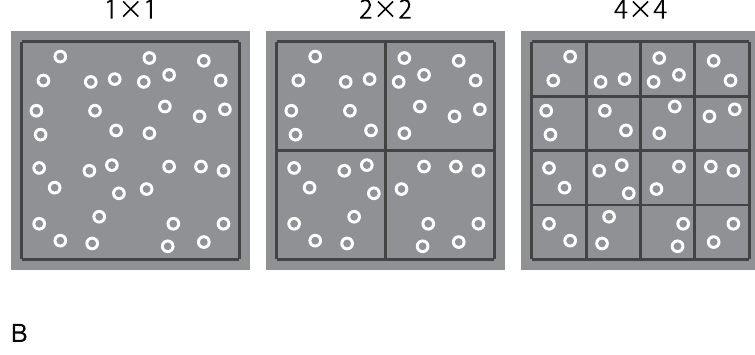
play contained a frame that segregated the large stimulus region into four smaller regions (each subdivided area subtended 6.2° × 6.2°). In the 4 × 4 divider condition, the entire stimulus region was divided into sixteen smaller regions (each subdivided area subtended 3° × 3°). In all divider conditions, circles were placed within a 4 × 4 grid (coincided with the 4 × 4 divider, but was invisible in the 1 × 1 and 2 × 2 divider condition). The position of each circle was randomly selected from 64 slightly jittered possible positions with the following constraints. For numerosities less than 16, each cell of the 4 × 4 grid contained zero or one circle. For numerosities between 16 and 32, each cell contained one or two circles. For numerosities larger than 32, each cell contained two or three circles. As mentioned before, visual displays without clustering and spatial regularity were preferred in the current study to avoid potential confounding effects. The constraints used here served to distribute stimuli relatively evenly throughout the display while keeping the spatial regularity low. Procedure.